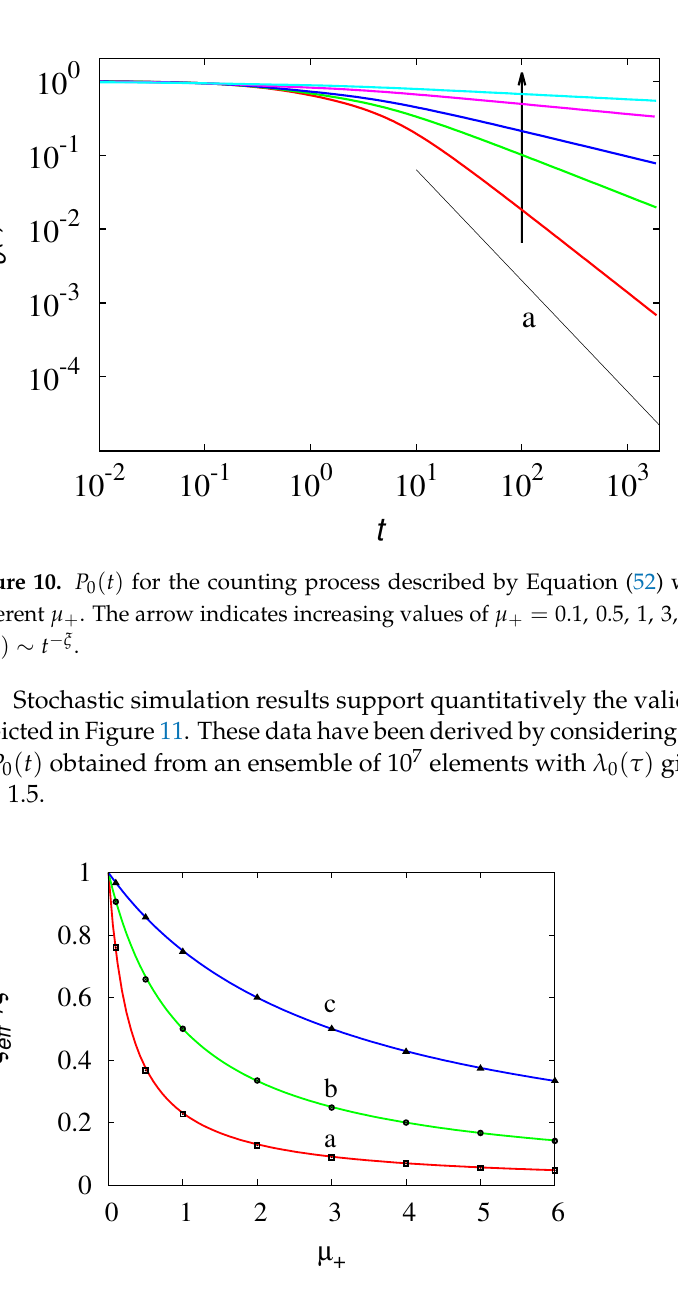
Figure 11. ξ eff / ξ vs. µ + for the asymmetric ES counting process described in the main text. Lines correspond to Equation (57), symbols represent the results of stochastic simulations. Lines (a) to (c) refer to µ − 0.3,1,3,